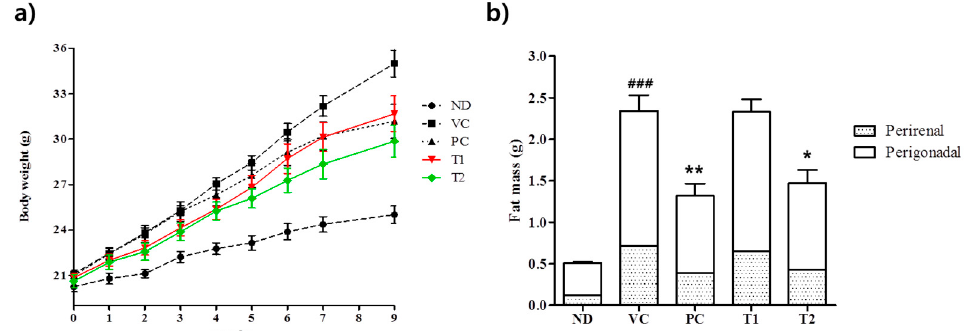
Figure 4. Effects of A. melanocarpa extract on body weights ( a ). Perirenal and perigonal fat masses ( b ) of mice fed a HFD for eight weeks. Results are presented as means ± SDs ( n = 12). Weights in the A. melanocarpa -treated and Orlistat-treated HFD groups were significantly lower than those in the HFD group; ### p < 0.001 vs. the ND group; * p < 0.05 and ** p < 0.01 vs. the VC group. Group I (ND), normal diet group; Group II (VC), high-fat diet group; Group III (PC), Orlistat-treated group; and Group IV (T1), 100 mg/kg b.w. A. melanocarpa extract-treated group; Group V (T2), 200 mg/kg